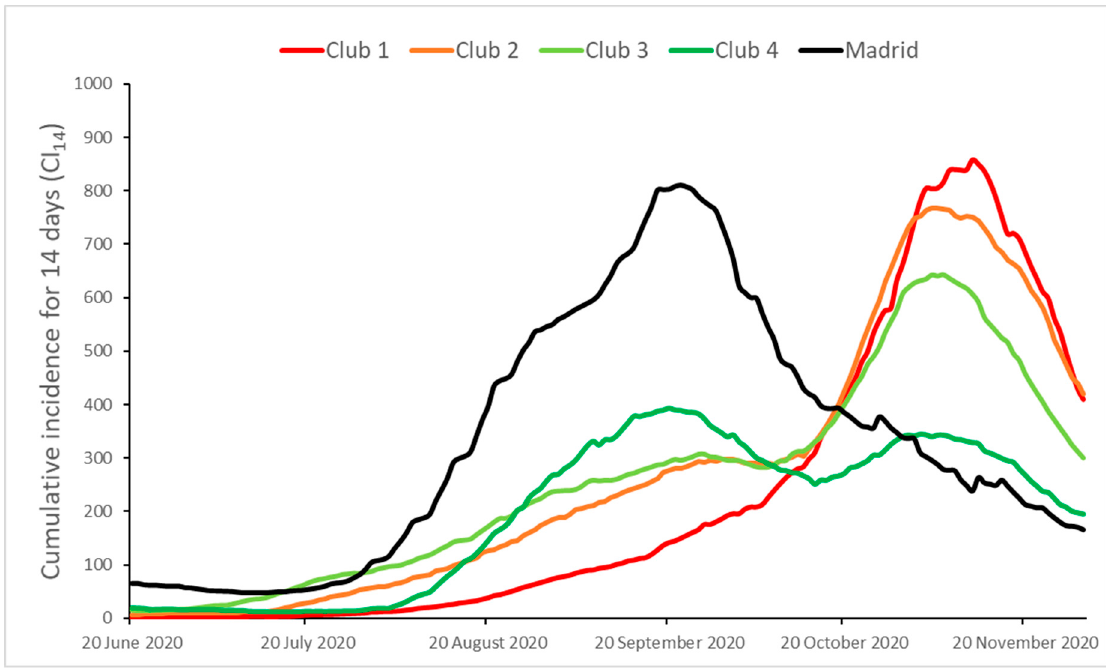
Figure 3. Average values of the estimated